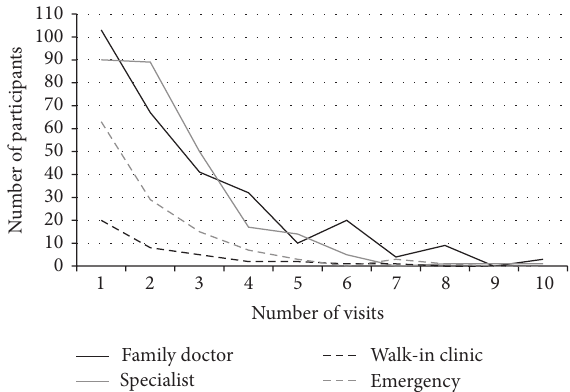
Figure 1: Number of healthcare visits for pain during 12 months prior to surgery. Number of participants with no visits in previous year: family doctor = 283, specialist = 317, walk-in clinic = 548, and emergency = 468. Number of participants with more than 10 visits in previous year (included in the group with 10 visits): family doctor = 15, specialist = 3, and walk-in clinic = 2.